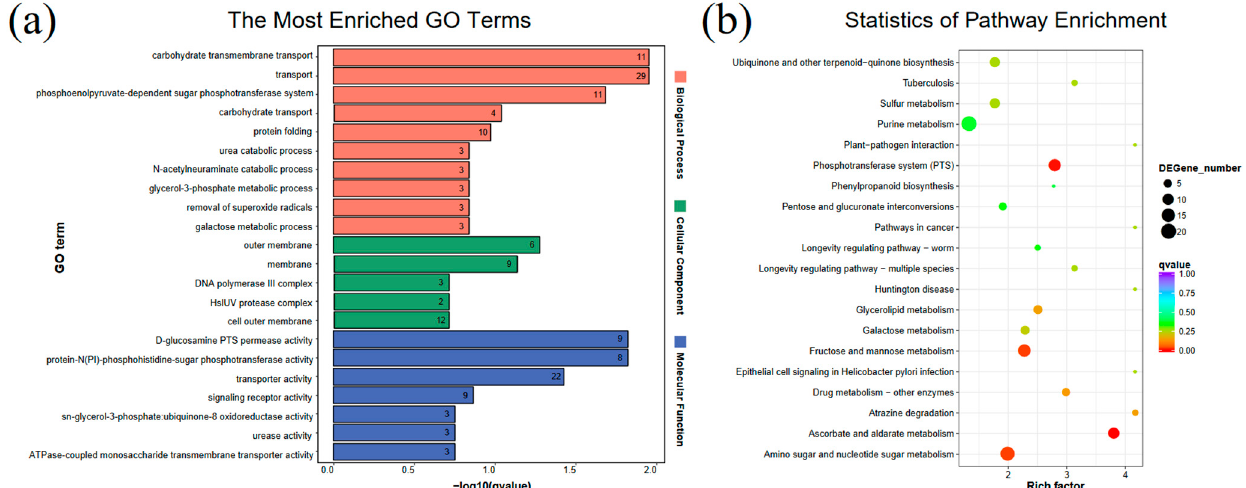
Figure 2. RNA-sequencing analysis. ( a ) GO enriched analysis. Number on the bar chart indicates the number of genes enriched under the term ( b ) and KEGG pathway enriched analysis for up-regulated and down-regulated genes.